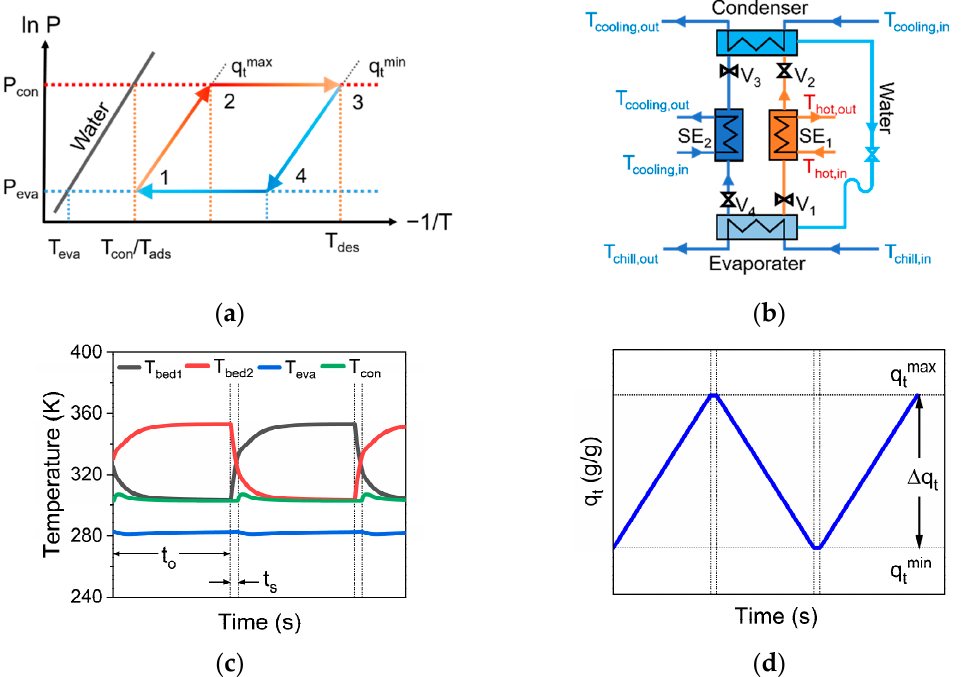
Figure 2. Schematic diagram of ( a ) thermal dynamic cycle, ( b ) two-bed adsorption cooling system, ( c ) transient temperature, and ( d ) transient water uptake in ACS.